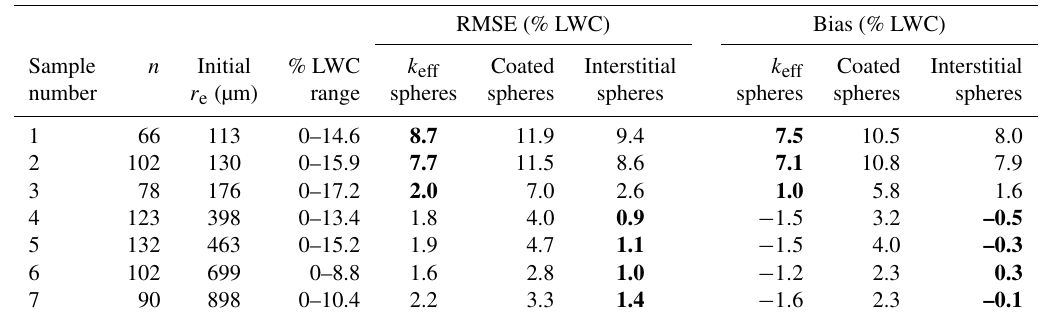
Figure 9. Comparison of LWC measured with the SLF Snow Sensor versus the mean LWC retrieved from NIR-HSI using the residual method. Three optical property mixing models are compared using the same datasets: (a) k eff spheres, (b) coated spheres, and (c) interstitial spheres. The initial (dry) effective grain radius for each sample is shown in the legend, and the R 2 value is for the best fit line, which excludes 113 and 130µm datasets. Table 2. Liquid water content retrieval results from the laboratory (reported r e is from scaled band area method). Bold values indicate the lowest RMSE and bias for a given